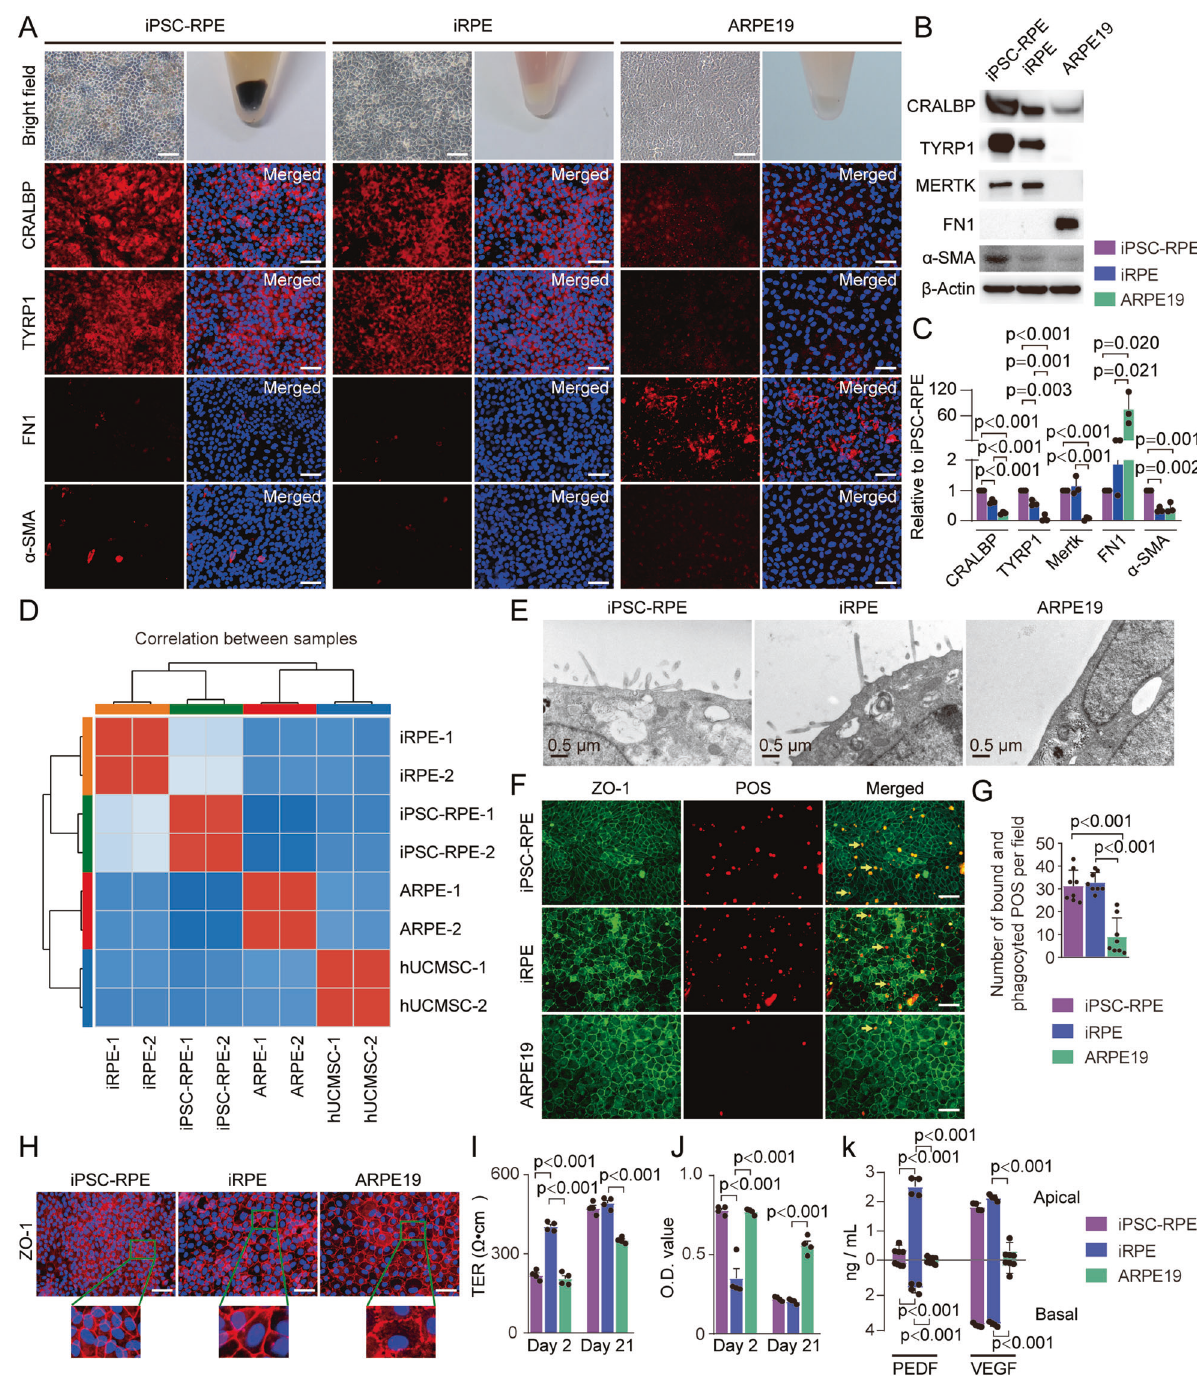
Fig. 2 iRPE cells exhibit comparable characteristics with iPSC-RPE cells. Pigment generation, RPE-speci fi c and EMT-associated markers in iPSC-RPE cells, iRPE cells, and ARPE19 cells were detected by A pigment generation and immunostaining, B Western blotting and C quantitative analysis ( n = 3). D The Pearson correlation coef fi cient matrix of all samples based on RNA-seq datasets. E Electron micrographs of iPSC-RPE cells, iPRE cells, and ARPE19 cells. F Total bound and phagocyted POSs (pointed by arrows) in iPSC-RPE cells, iRPE cells, and ARPE19 cells. G Quanti fi cation of phagocytosis, as determined by the number of bound and phagocyted POS per fi eld ( n = 8). H Tight junction were demonstrated by ZO-1 immunostaining. I TER analysis ( n = 4). J HRP permeability assay ( n = 4). K Expression levels of PEDF and VEGF from upper and lower chambers were determined by ELISA ( n = 4). Scale bar = 50 μ m. Results are expressed as mean ± SD. P value measured by one-way ANOVA and post hoc Bonferroni ’ s test.